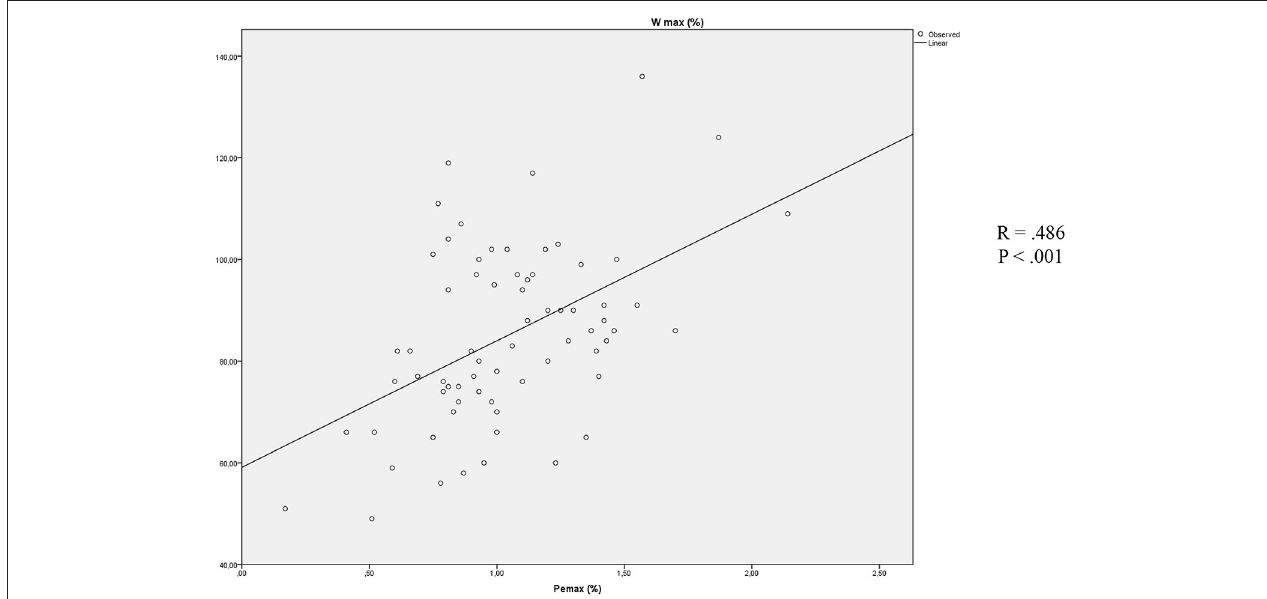
FIGURE 1 | Association between Pe max and W max